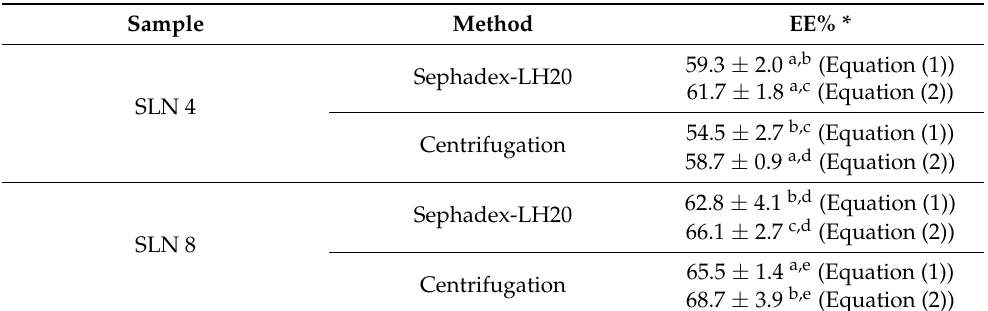
Table 3. Entrapment efficiency (EE) determination of BXL in SLN4 and SLN8. Data are reported as mean ( n = 3) ± SD.